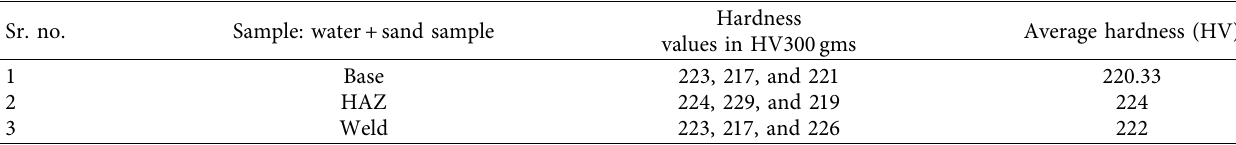
Table 3: Microhardness values in sample 3 (tempered in water+sand).